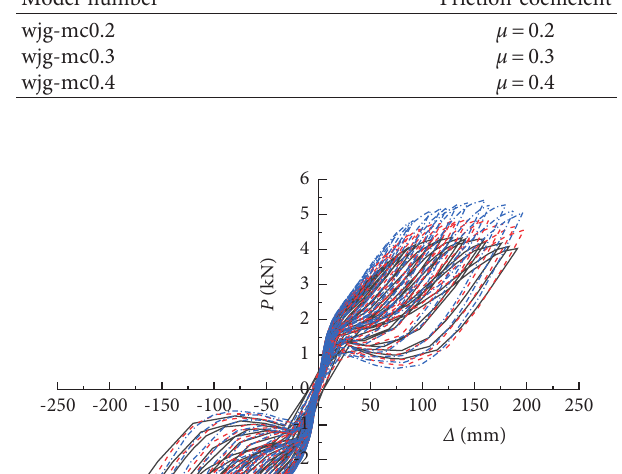
Figure 21: Displacement of group B models at 4.21 kN.